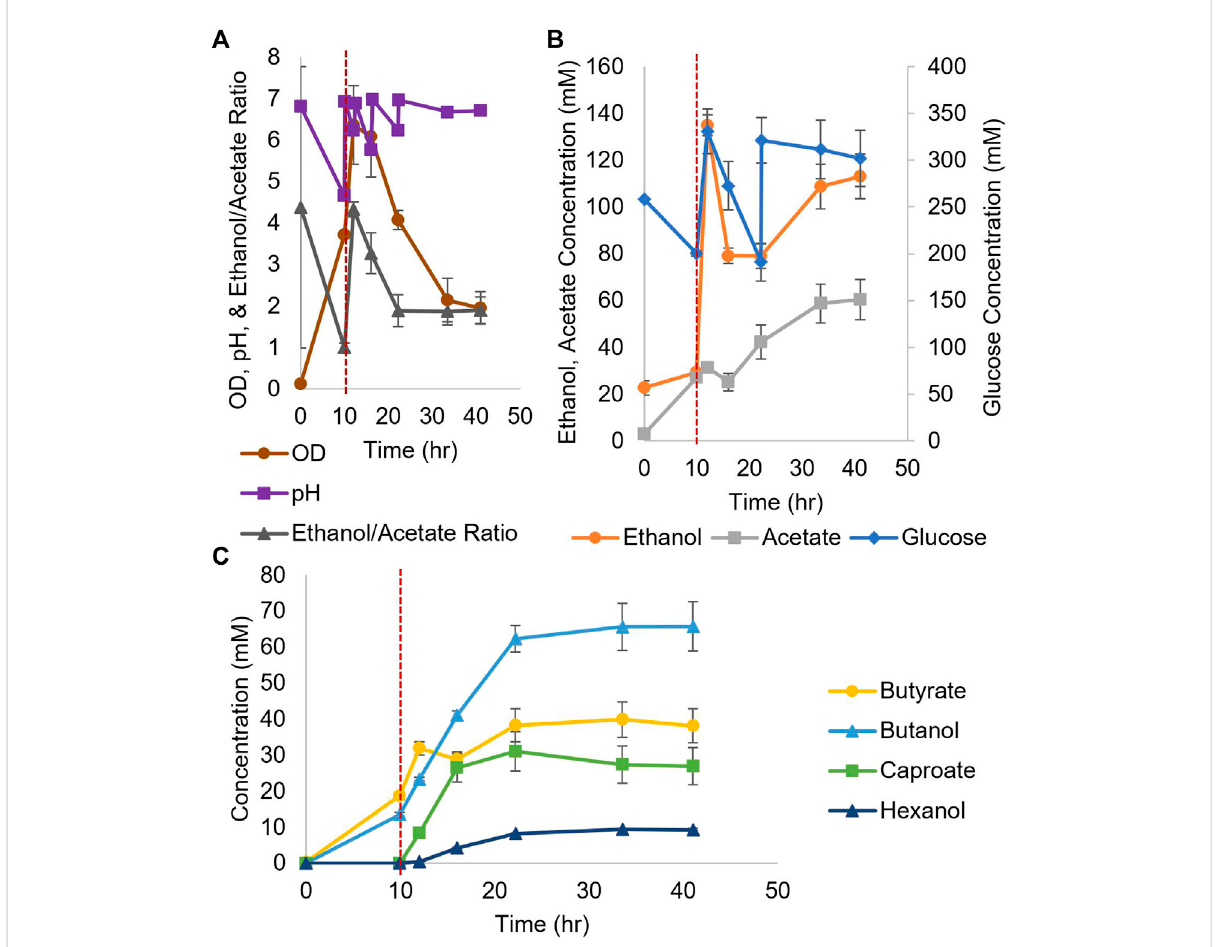
FIGURE 4 Growth and metabolite pro fi les of Cac (pCASAAD)/ Ckl cocultures. (A) The pro fi les of OD 600 , pH, and the ethanol/acetate ratio ( n = 3 biological replicates).ThepHwasraisedthreetimestokeepitlargelyover6,andasaresultOD 600 ofthecoculturedroppedquicklyapparentlyduetoautolysin productionby Cac asdiscussedinthetext. (B) Theglucosepro fi leandconsumption(glucosewasaddedtwice;notethesecondaxis)andthepro fi les of ethanol and acetate produced by Cac . Pro fi les of 4- and 6-C products are shown in (C) . Caproate was produced quickly, reaching its maximum value in about 20 hours. The red dashed vertical line indicates Ckl